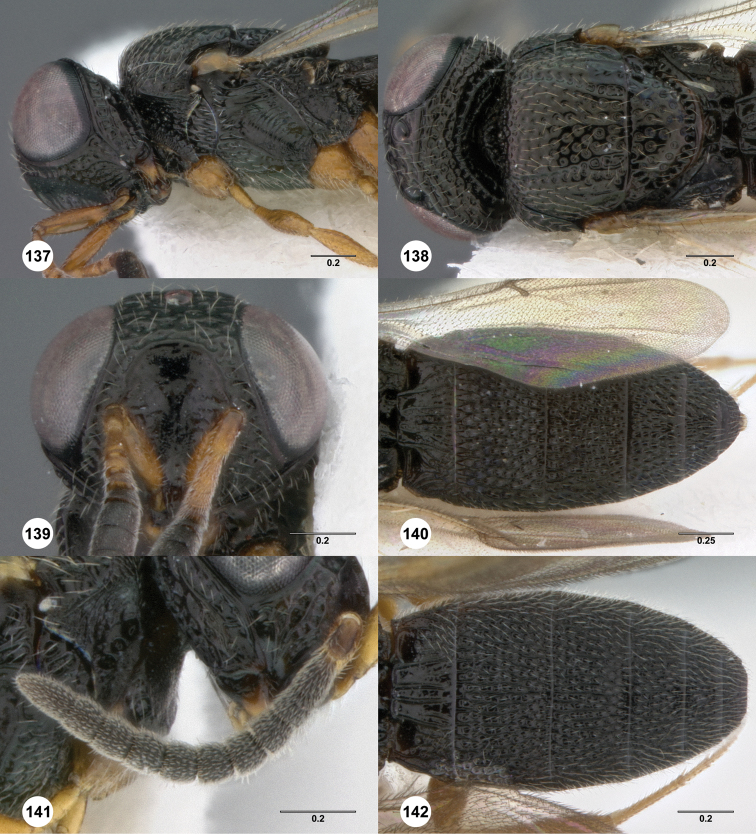
Oxyscelio hyalinipennis (Dodd), female (OSUC 437885) 137 Head and mesosoma, lateral view 138 Head and mesosoma, dorsal view 139 Head, anterior view 140 Metasoma, dorsal view. Male (OSUC 437979) 141 Antenna 142 Metasoma, dorsal view. Morphbank54